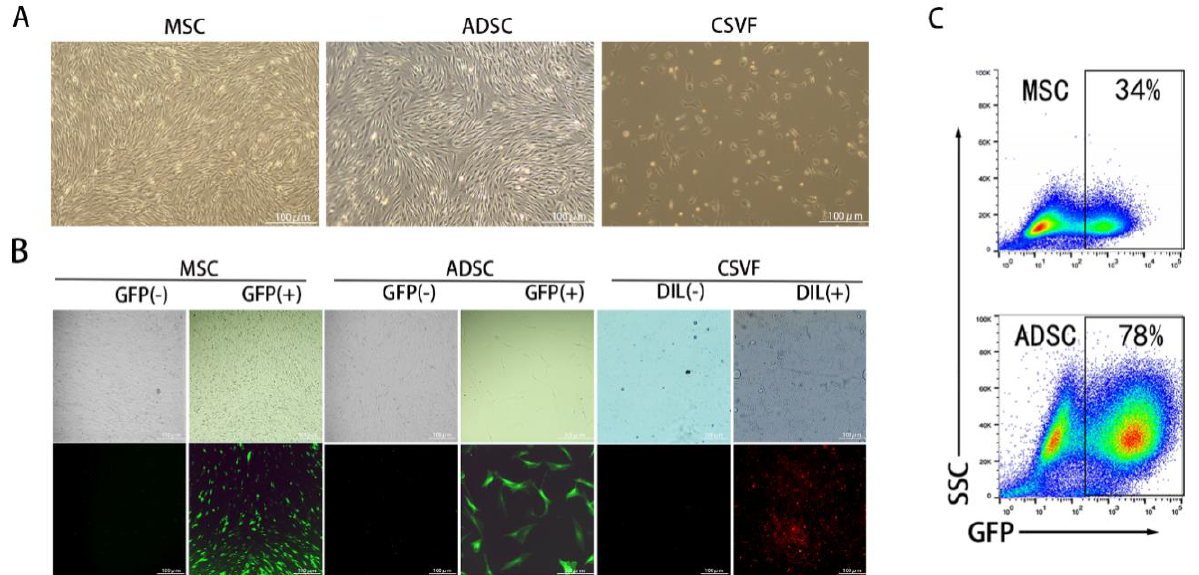
Figure 2. Cell morphology and fluorescent labeling of MSC, ADSC and CSVF. ( A ) Morphology of MSC and ADSC in culture and morphology of CSVF after extraction and change of culture medium. ( B ) The first row shows the phase contrast images of MSC, ADSC in the culture dish ready for sorting and the image of CSVF extracted from rat adipose tissue. The second row shows the fluorescence images of MSC, ADSC, and DIL-stained CSVF after transfection with lentivirus in order. ( C ) the flow cytometric analysis of MSC and